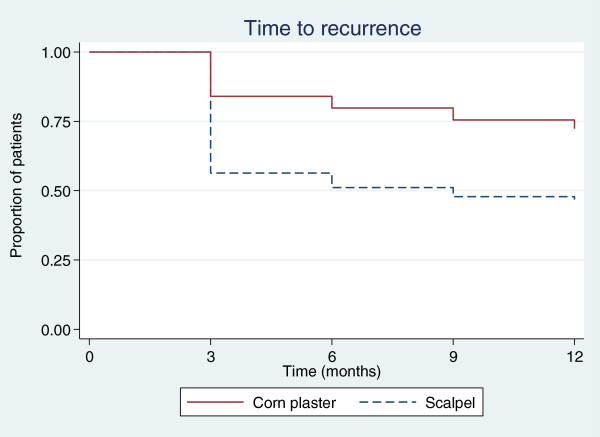
Time to corn recurrence.